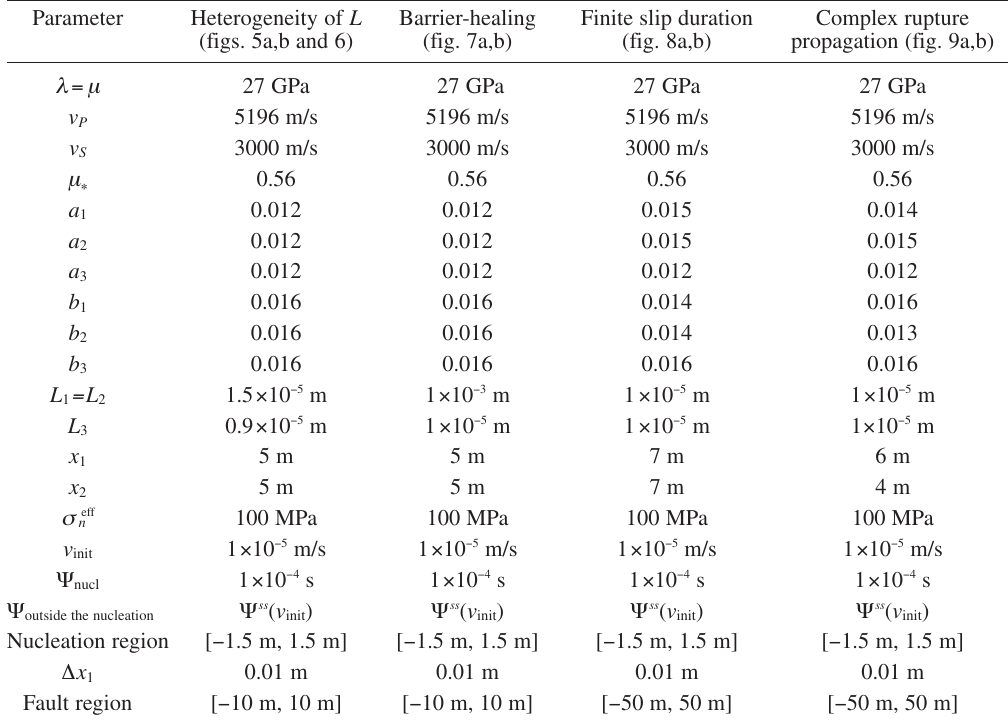
Table III. Model and constitutive parameters used for the simulations on a heterogeneous fault. Parameter Heterogeneity of L Barrier-healing Finite slip duration Complex rupture (figs. 5a,b and 6) (fig. 7a,b) (fig. 8a,b) propagation (fig.